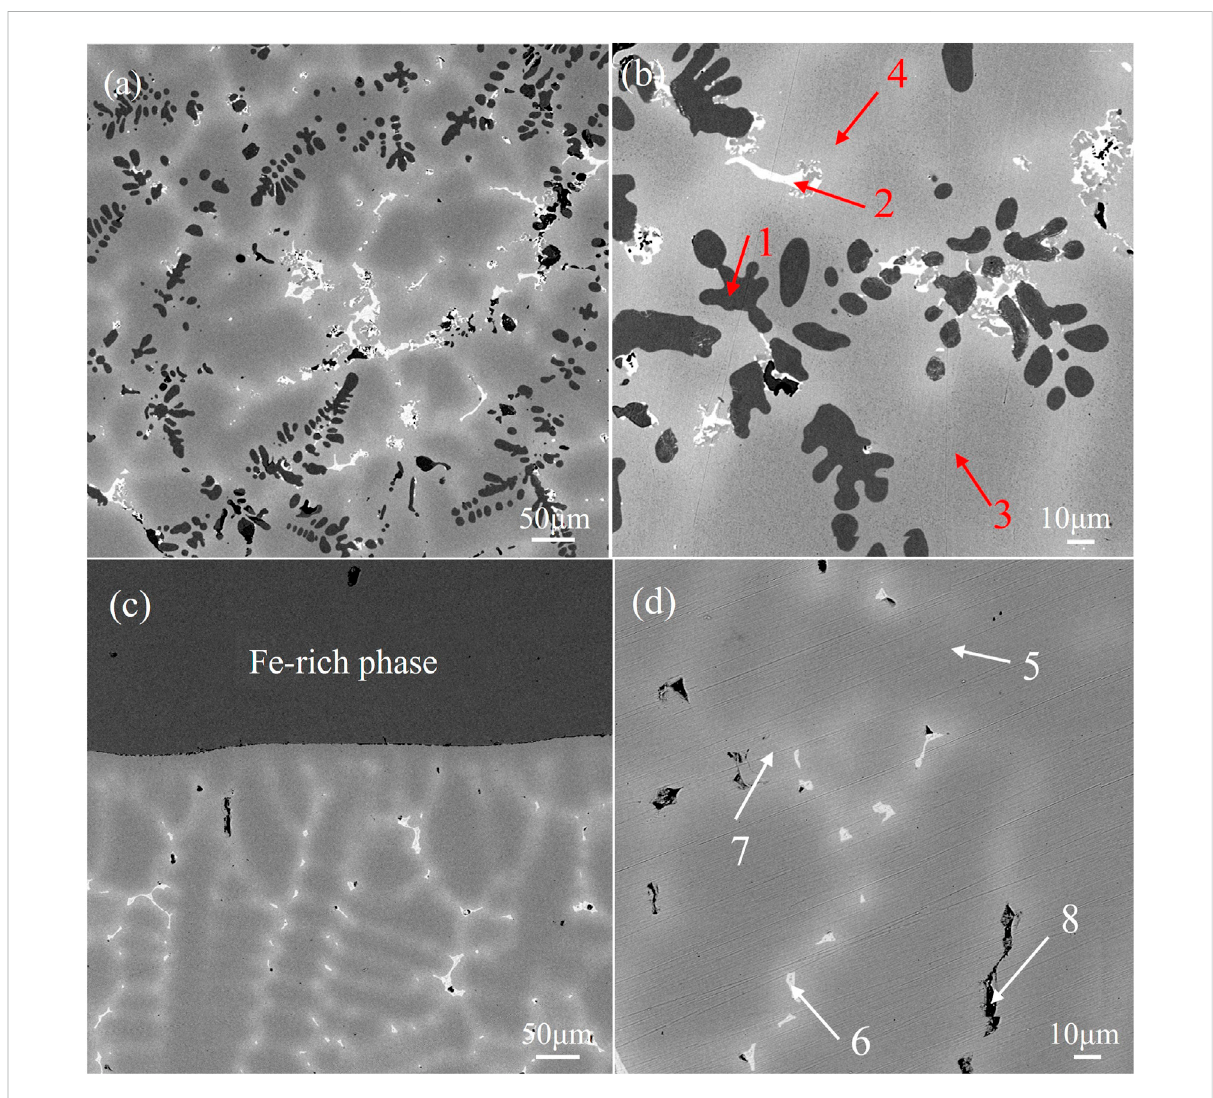
FIGURE 2 Microstructure of alloys (A) (B) alloy obtained by melting the circuit board and (C) (D) alloy obtained by pure